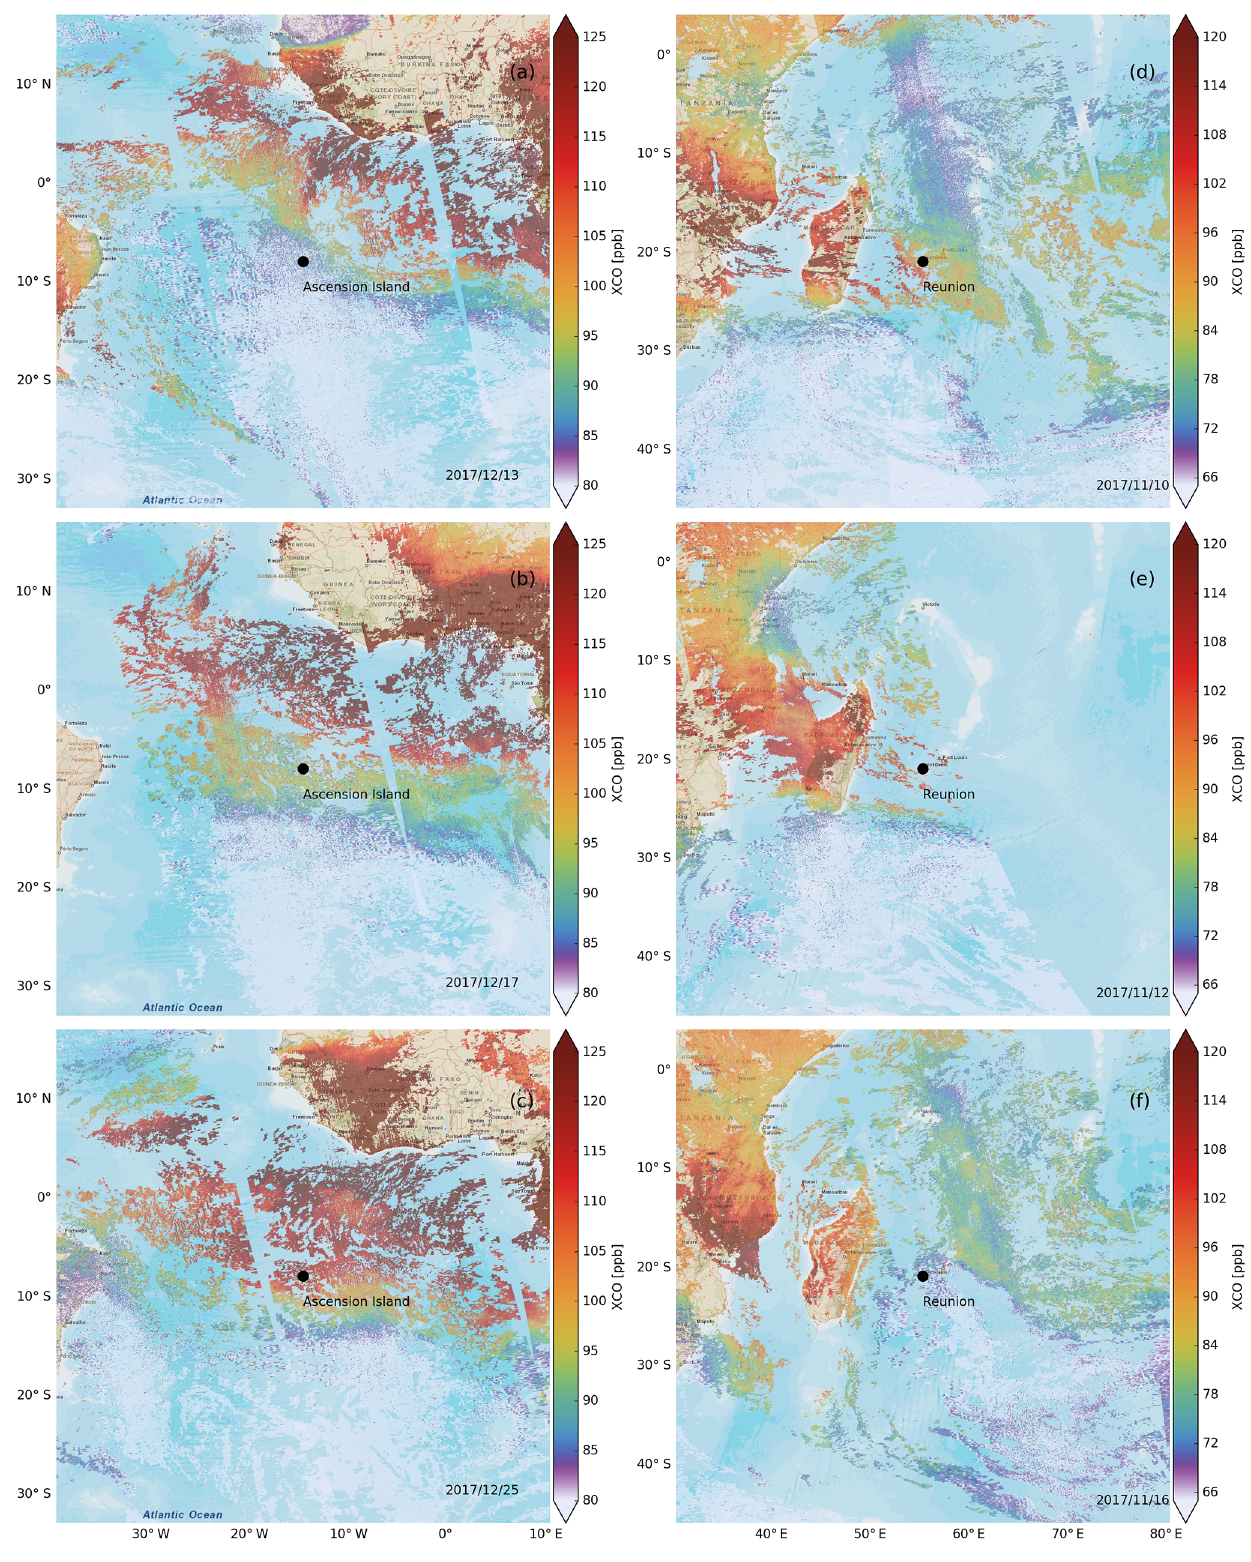
Figure 8. Total column mixing ratio (XCO) for individual TROPOMI ground pixels near Ascension Island on (a) 13 December 2017, (b) 17 December 2017, and (c) 25 December 2017 and near Réunion on (d) 10 November 2017, (e) 12 November 2017, and (f) 17 November 2017. De-striping was applied on the TROPOMI